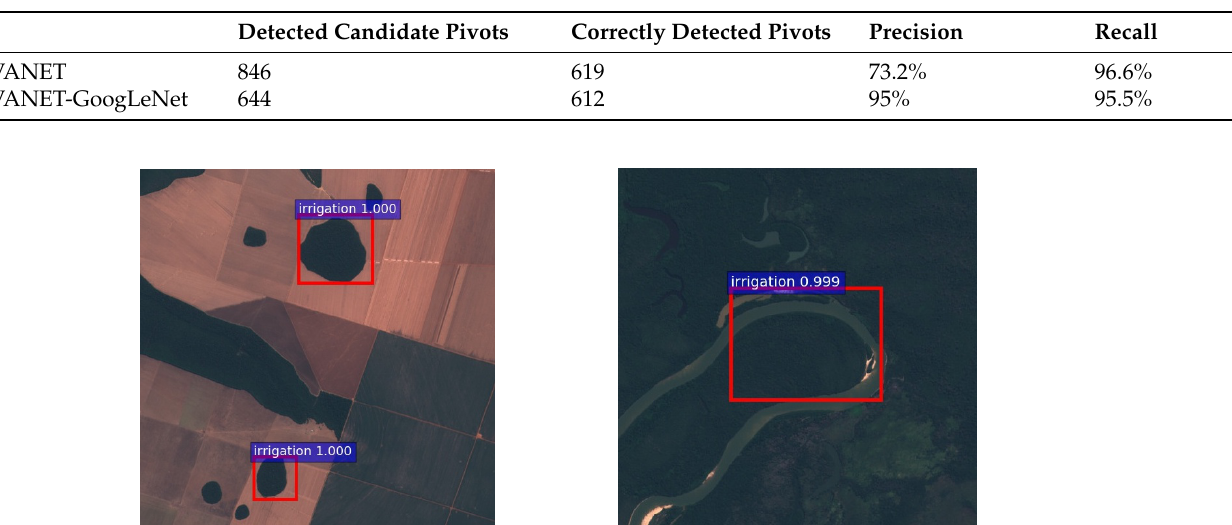
Table 1. The result of the proposed method.